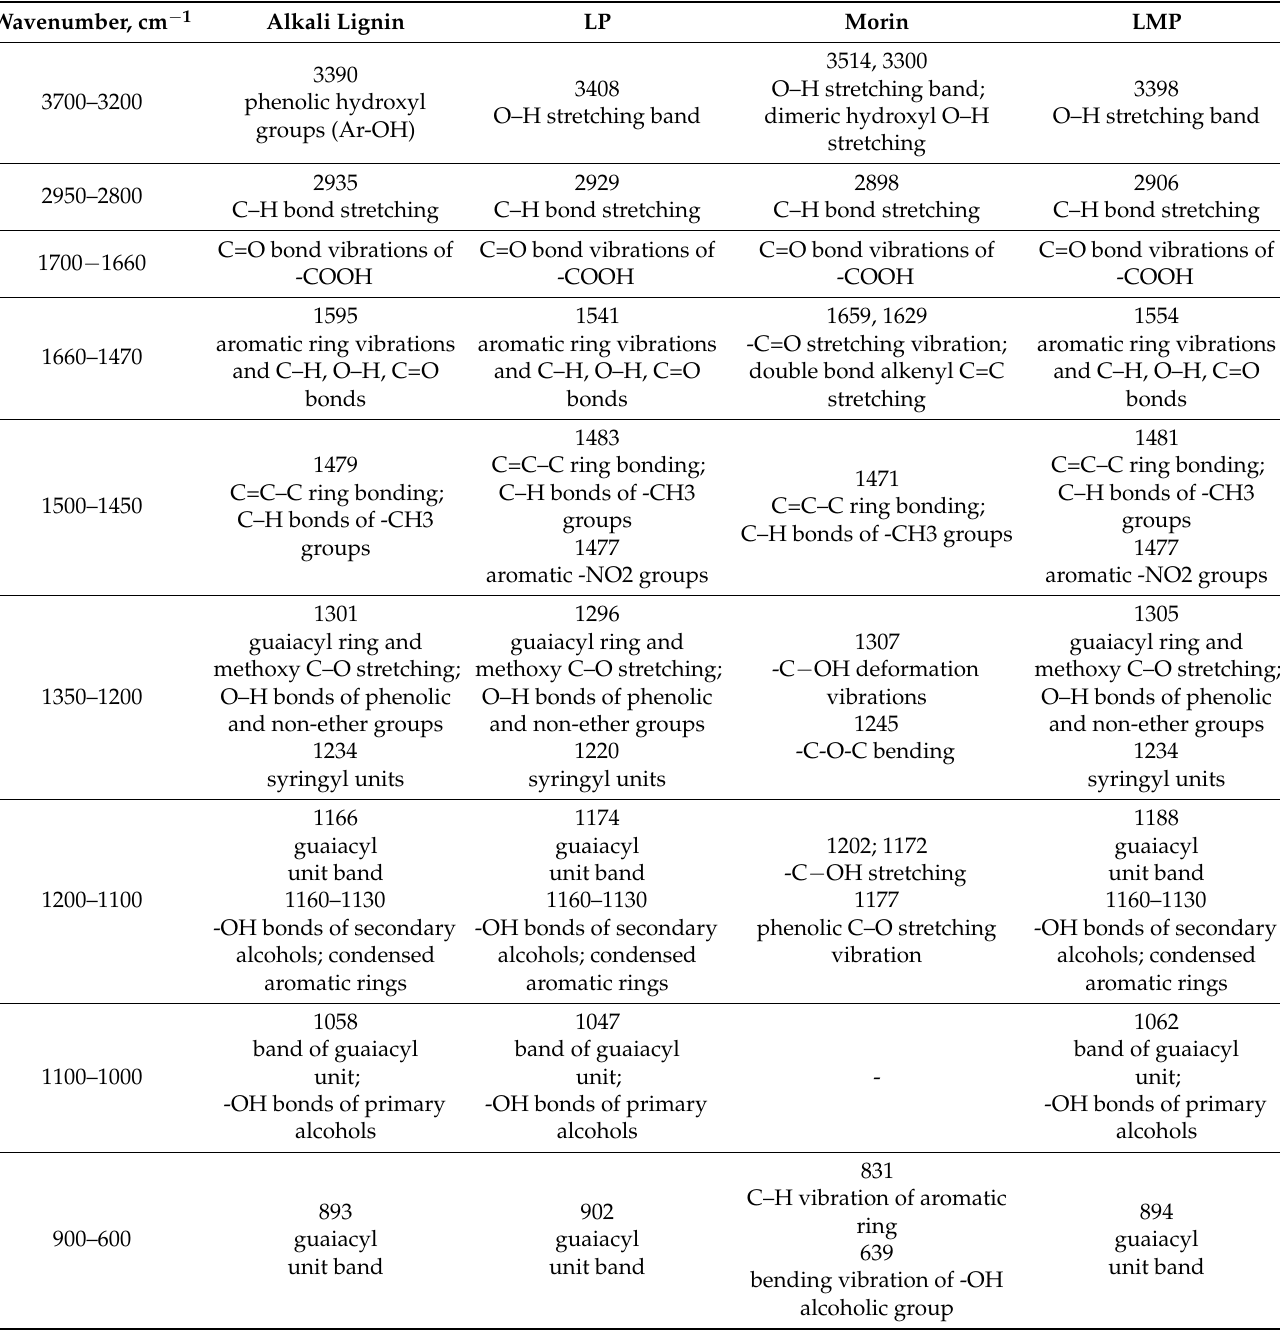
Table 1. FTIR spectra assignments of morin, alkali lignin, LPs and LMPs [22,23]. Wavenumber, cm −